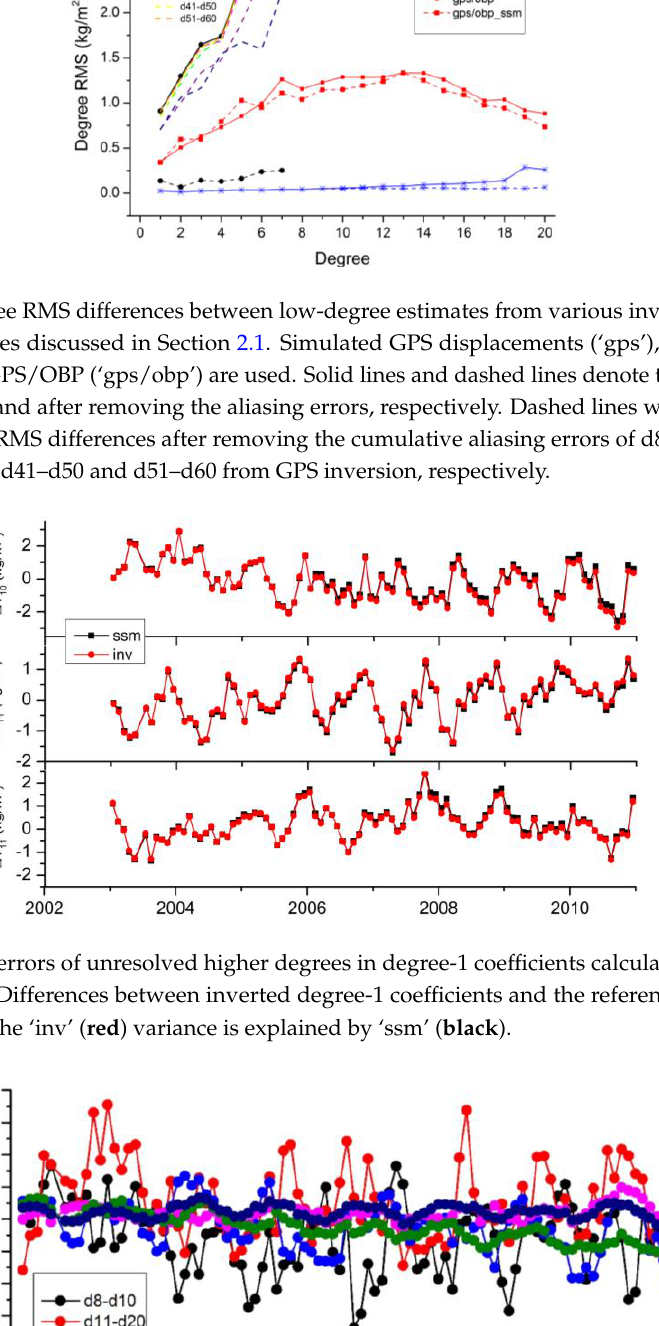
calculated by the SSM approach. 10